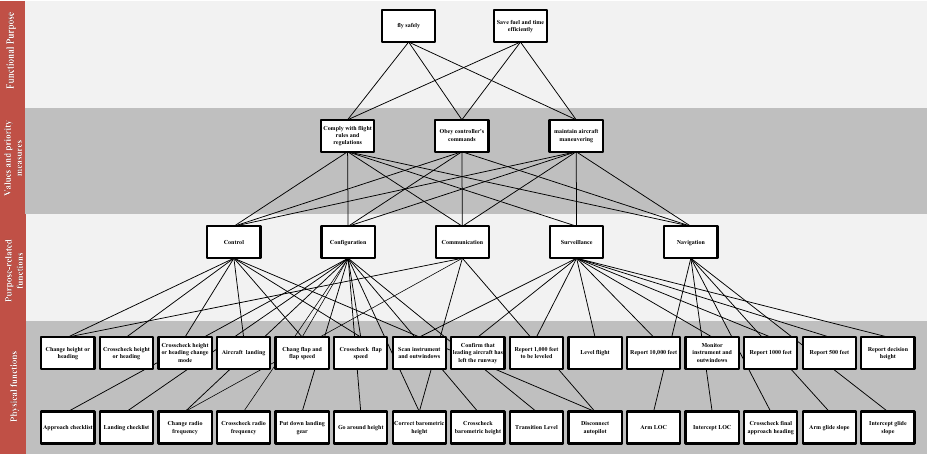
Figure 3. A detail of the abstraction hierarchy of current two-crew